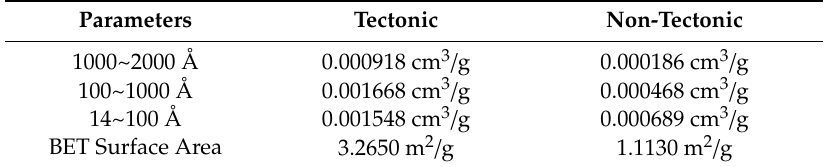
Table 4. Pore volume and specific surface area derived from low-temperature liquid nitrogen